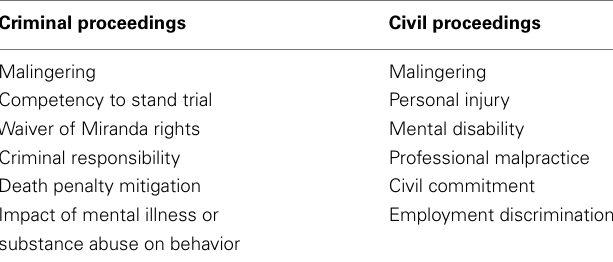
Table 2 | Questions that arise during the adjudication